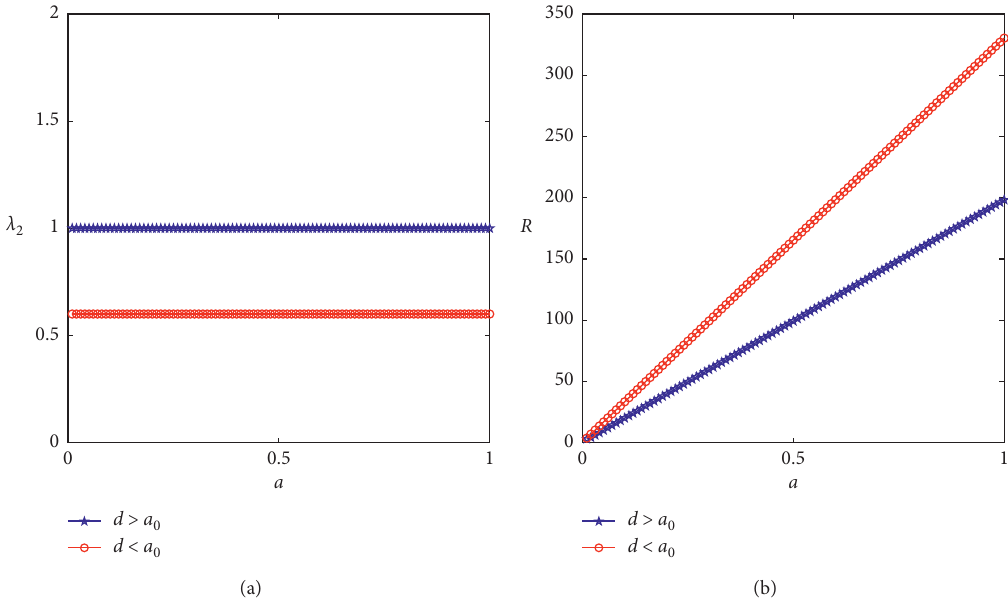
Figure 11: When N is odd, the synchronizability of Network II changes with the intralayer coupling strength a from the leaf nodes to the changes with a ( a changes from 0.01 to 1); (b) R changes with a ( a changes from 0.01 to 1). hub nodes. (a) λ 2